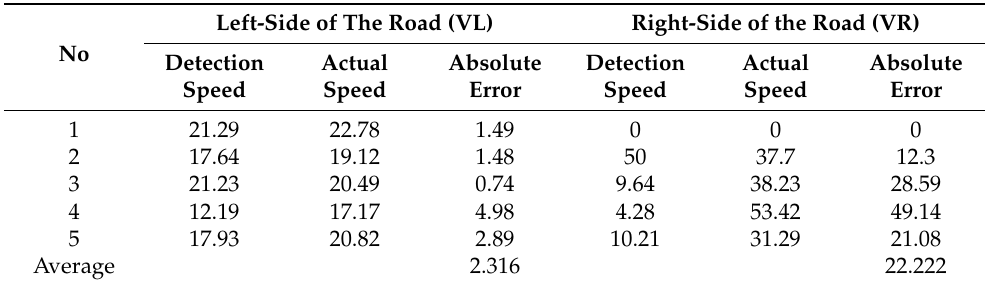
Table 12. Error rate (km/h) for vehicle speed calculation on Trunojoyo road segment. Left-Side of The Road (VL) Right-Side of the Road (VR) No Detection Actual Absolute Detection Actual Speed Speed Error Speed Speed